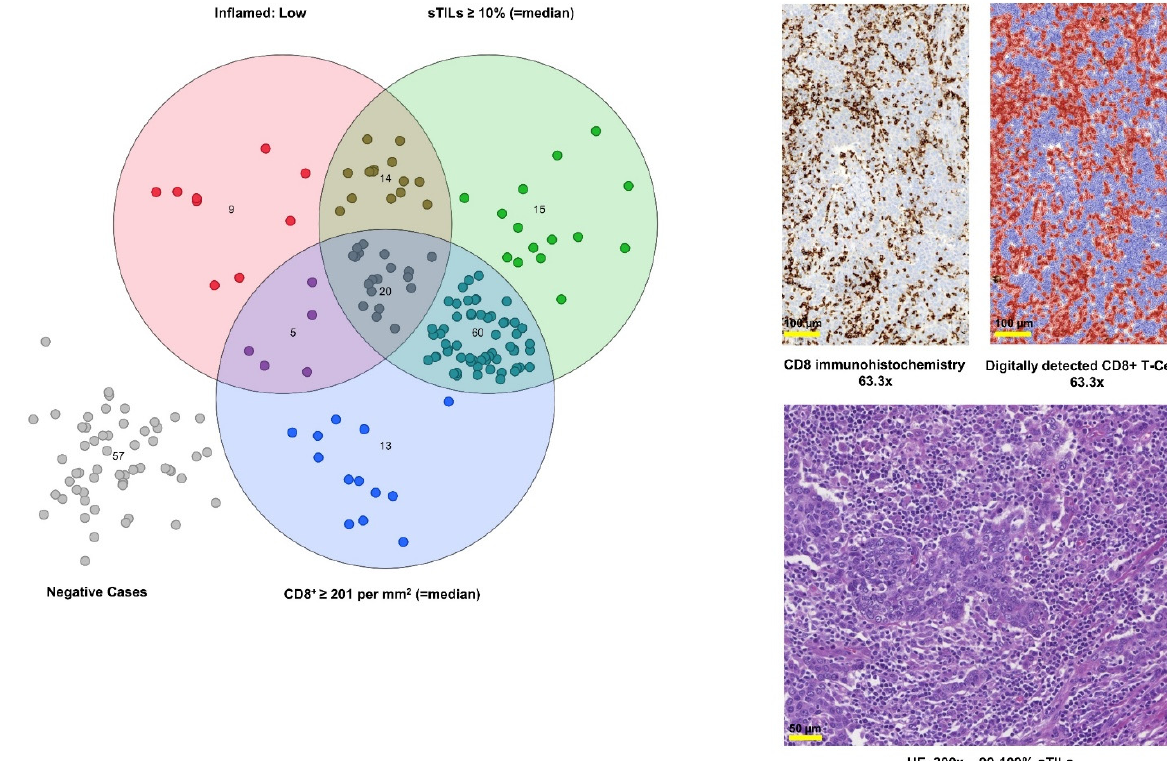
Figure 5. Scoring of sTILs and digital quantification of tumor infiltrating CD8 + T-cells detected in inflamed tumors with low PD-L1 expression (“Inflamed: Low”). The Venn diagram illustrates the overlap of “Inflamed: Low” tumors with moderate immune infiltration and sTILs scoring on HE slides as well as digital CD8 + quantification. Images on the right illustrate digital CD8 + cytotoxic T-cell scoring (upper panel; 63.3 × magnification) and of sTILs scoring (lower picture; HE 200 × magnification). Abbreviations: HE = hematoxylin & eosin; sTILs = stromal tumor infiltrating